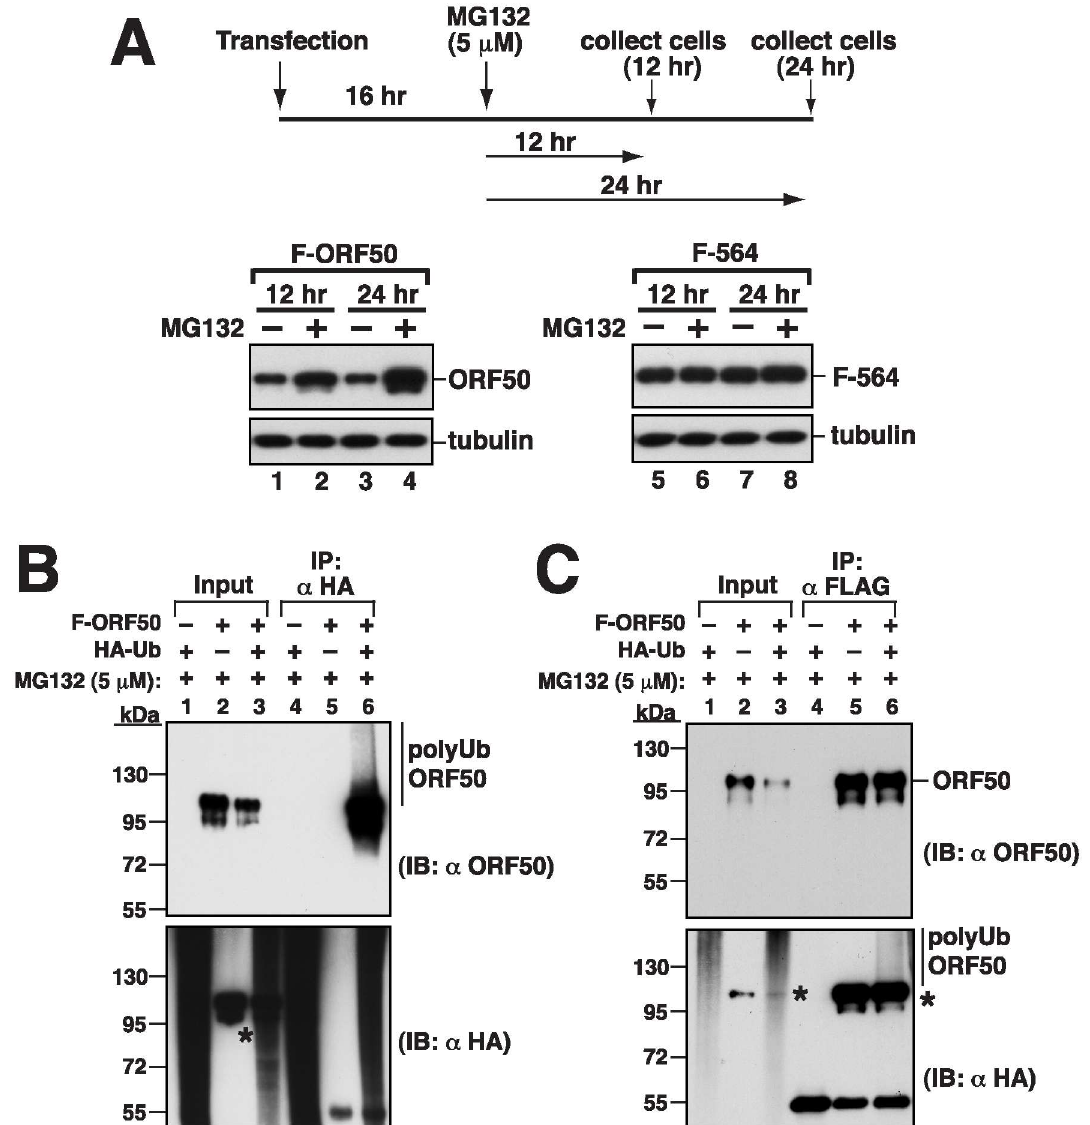
Fig 6. The protein abundance of ORF50 is controlled through the ubiquitin-proteasomal degradation pathway. (A) Effect of MG132 on ORF50 abundancein cells. 293T cells were transfected with a plasmid encodingF-ORF50 or F-ORF50 (1–564). At 16 hr after transfection, cells were untreated or treated with 5 μ M of MG132 for another 12 hr and 24 hr. Cell lysates were analyzedby immunoblotting using anti-FLAG antibody. (B and C) Ubiquitination of ORF50 in cells. 293T cells were transfected with plasmidsencodingHA-ubiquitin (HA-Ub) or/and F-ORF50. At 16 hr posttransfection, cells were treated with MG132 for another 24 hr. Denaturedlysates were immunoprecipitated (IP) with either anti-HA antibody (B) or anti-FLAG antibody (C). Cell lysates (input) and the immunoprecipitated proteins were analyzedby immunoblotting (IB) using anti-ORF50 or anti-HA antibody. Asterisks indicate the cross-reaction of ORF50 with the used antibodies(S4